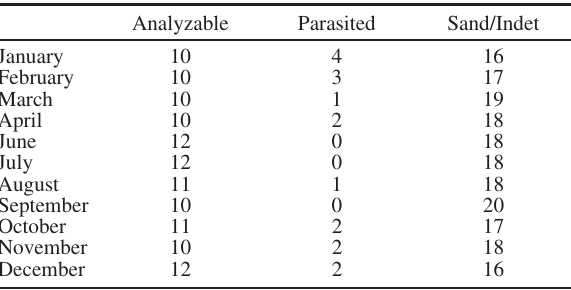
Table 1. – Number of individuals per gametogenic cycle of the 30 analysed per month. Analyzable